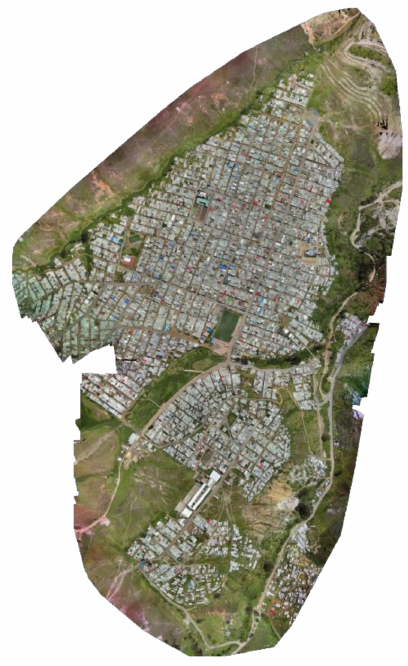
Figure 12. Satellite images for roof detection.